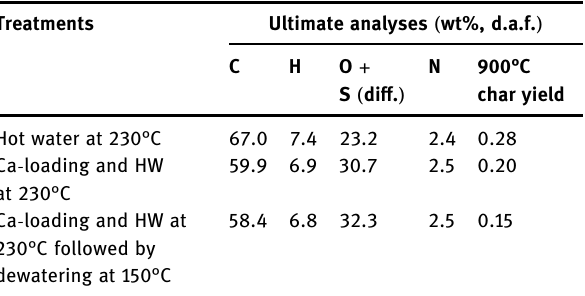
Table 2: Ultimate analyses of the treated co ff ee grounds and their char yields at 900°C Treatments